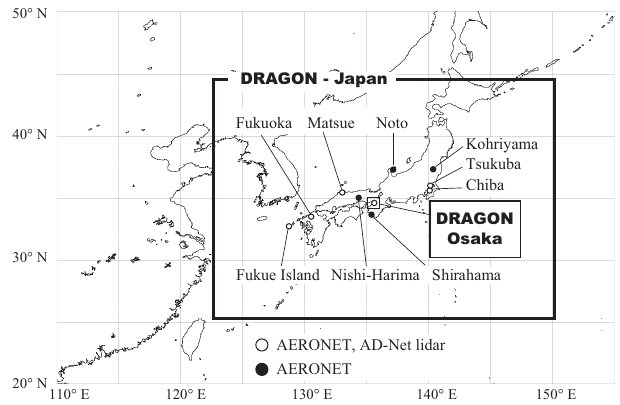
Figure 2. Geographical positions of observational sites for DRAGON-Japan in spring of